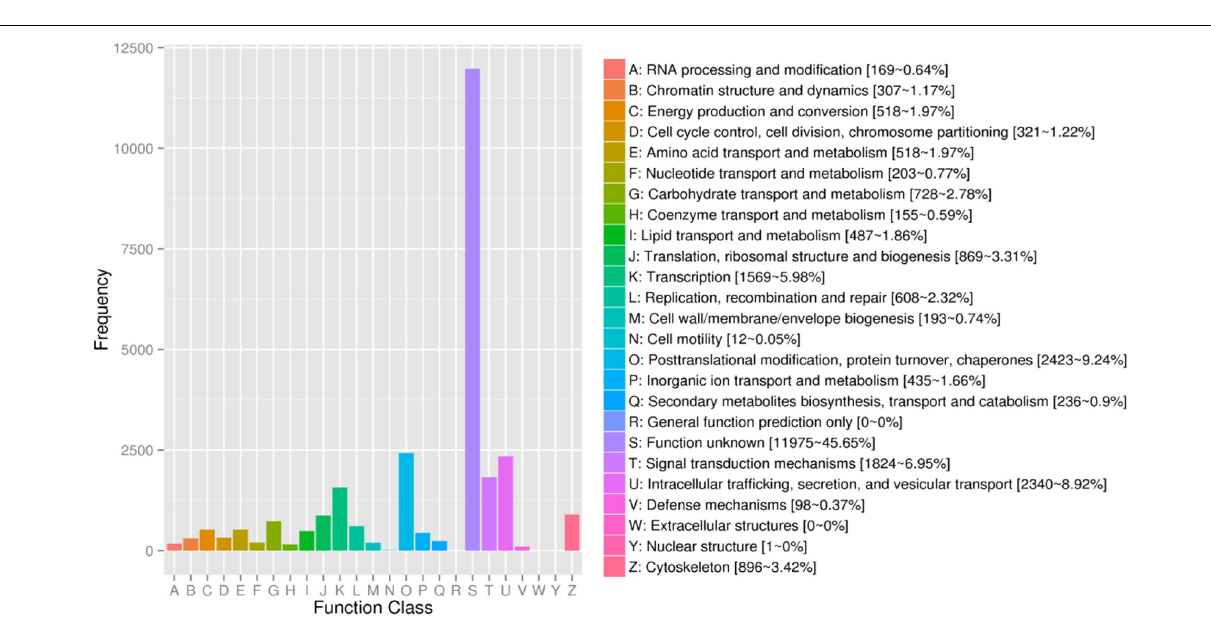
MF category, the DEGs were significantly enriched in catalytic activity and